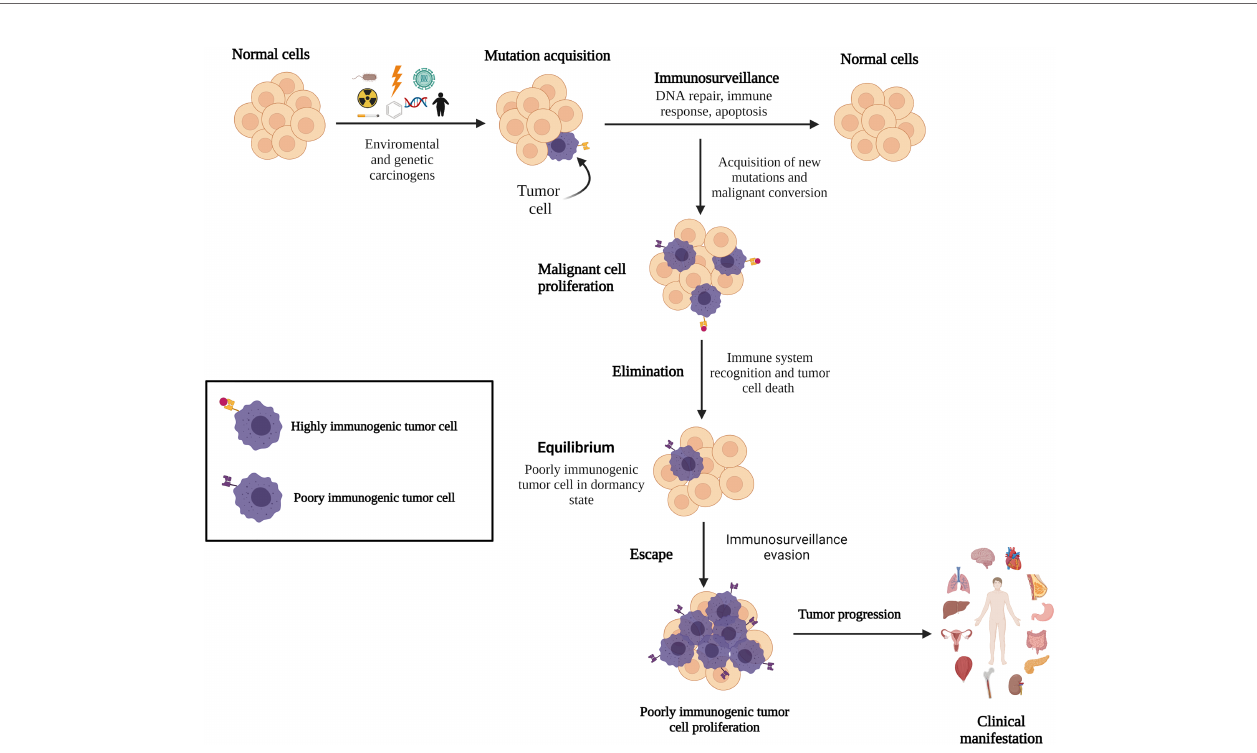
FIGURE 1 | Immune surveillance and cancer development. Emerging malignant cells are identi fi ed and eliminated by the immune system; however, certain acquired gene mutations in tumor cells allow them to remain undetected by the immune surveillance system, resulting in